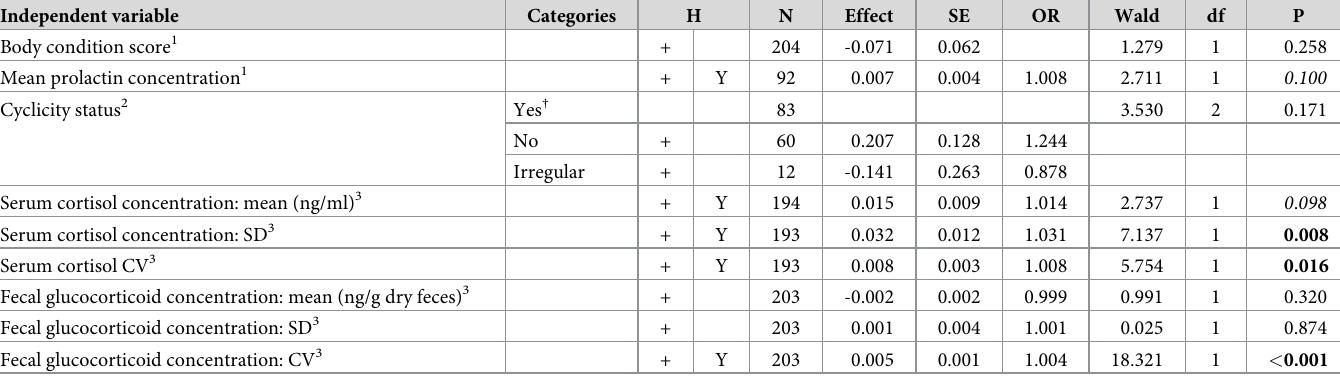
Table 7. Univariate analyses investigating relationships between welfare outcomes and the total number of clinical events in African and Asian elephants in North American zoos. Hypotheses (H): positive (+), negative (-), or neutral (/) relationship of each variable with the number of clinical events as a measure of elephant welfare, and whether observed relationships (P < 0.15) were in the predicted direction (Y yes / N no).